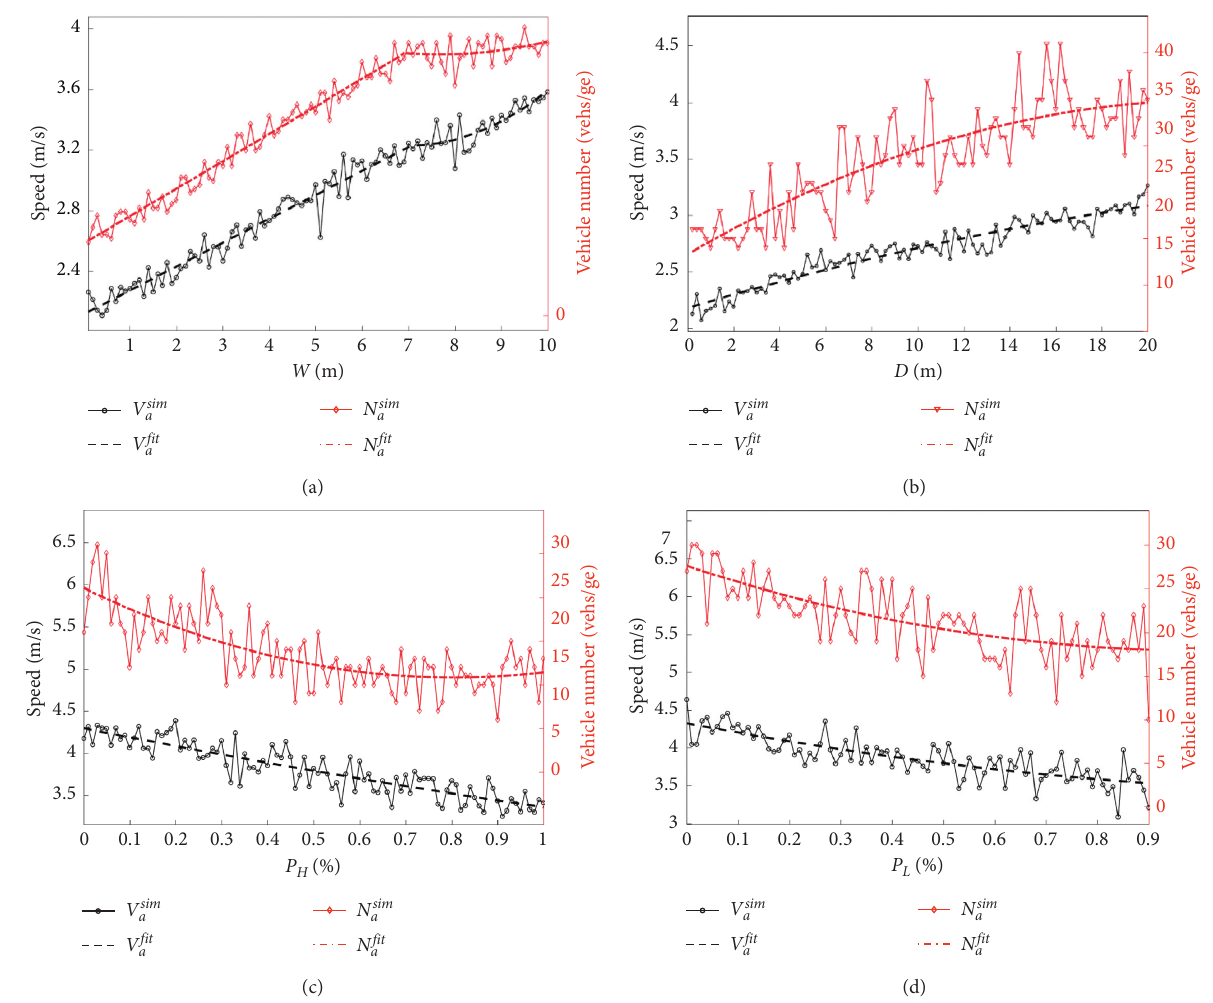
Figure 10: Simulation results for the three-leg intersection. (a) W . (b) D . (c) P